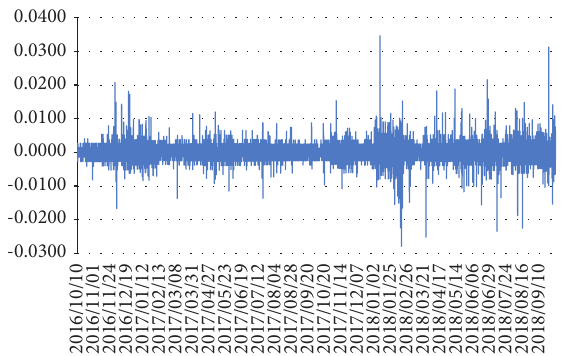
Figure 1: 601857.SH 5-minute high-frequency